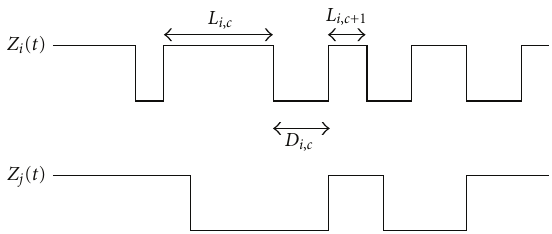
Figure 3: Up and down behaviors for peer p i and p j . Processes { Z i ( t ) } and { Z j ( t ) } are independent.